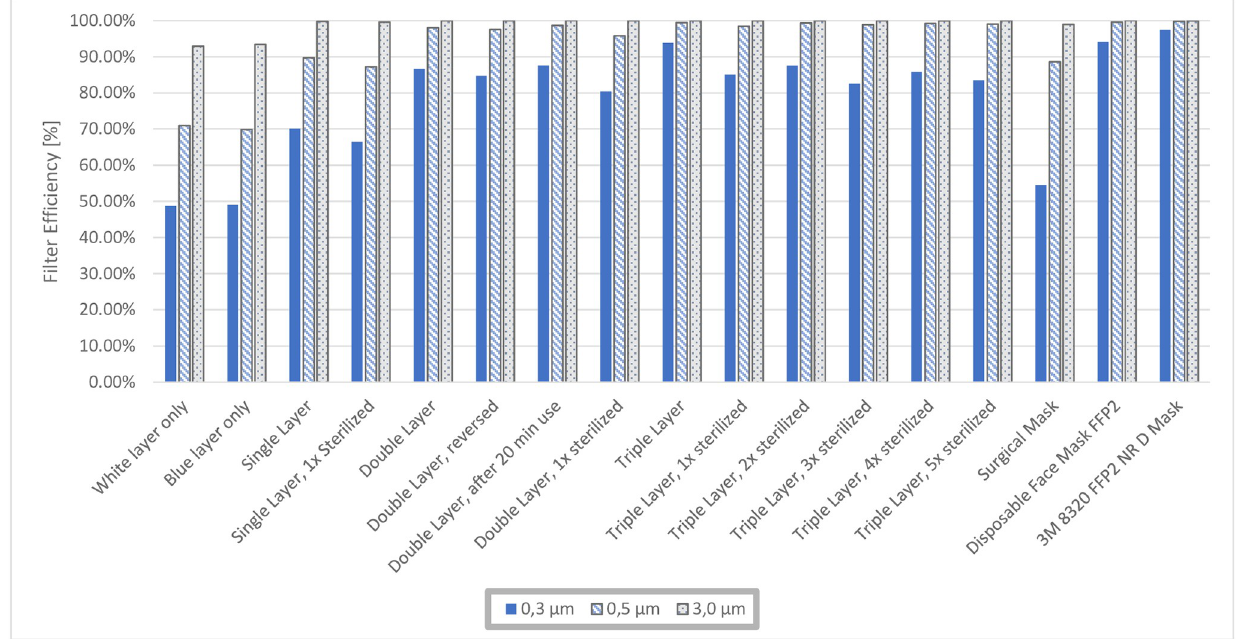
Fig 2. Summary of the filter efficiency of the indicated materials, including five rounds of sterilization at 121 degrees Celsius for the triple-layer material. For comparison, we also included a surgical mask and two types of FFP2 mask.